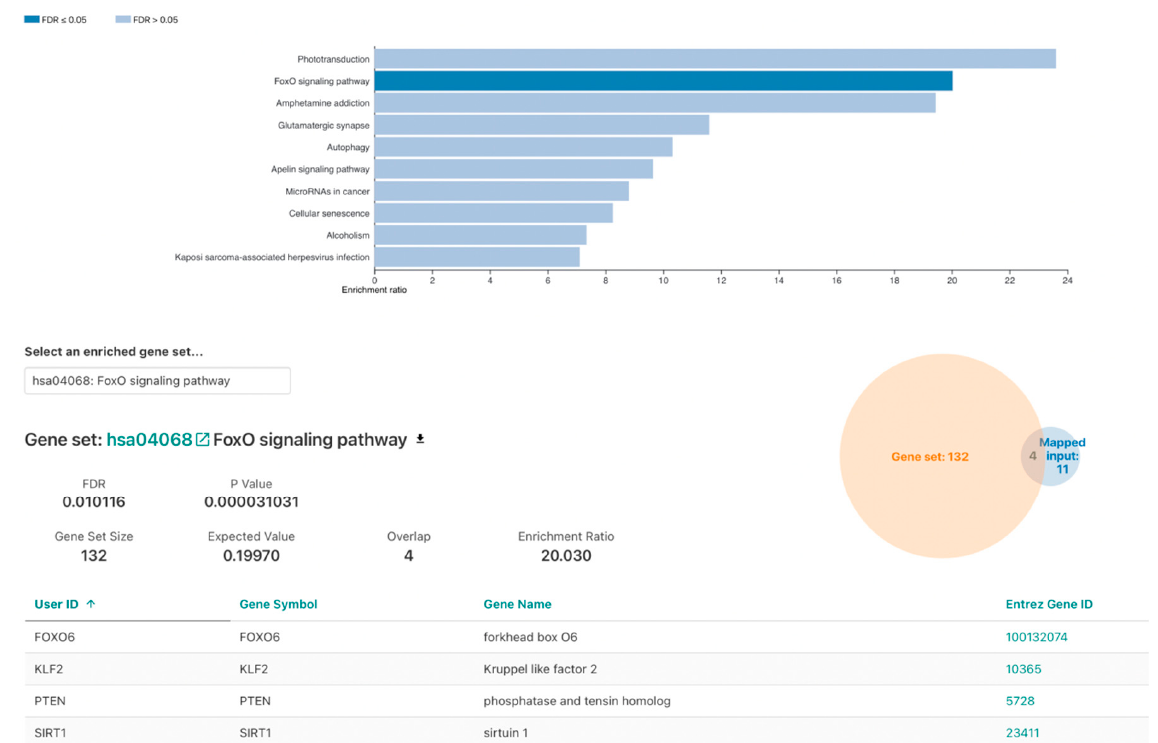
Figure 2. WebGestalt KEGG pathway ORA: FOXO signaling pathway.